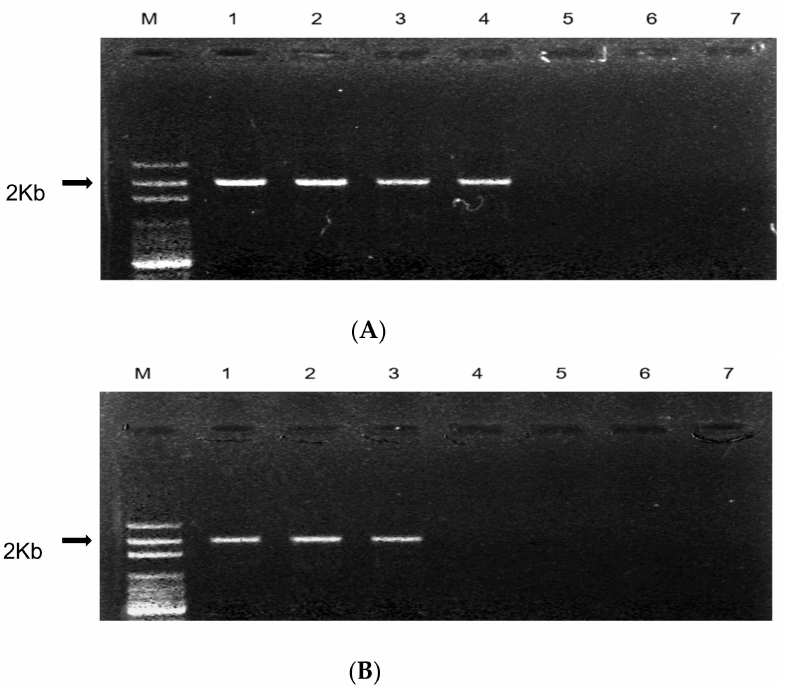
Figure 3. Identification of resistant onion lines of ‘Seeds & People’ Co. and ‘Asia Seed’ Co. using the SCAR-OPAN1 marker. ( A ) The 2-Kb-sized polymorphic products were amplified in the resistant lines (S&P 7522, S&P 7521, S&P 7129, and S&P 7168) and were not amplified in the susceptible lines (S&P 7483, S&P 7130, and S&P 7175). M: 100-bp DNA ladder marker, Lane 1: S&P 7522, Lane 2: S&P 7521, Lane 3: S&P 7129, Lane 4: S&P 7168, Lane 5: S&P 7483, Lane 6: S&P 7130, and Lane 7: S&P